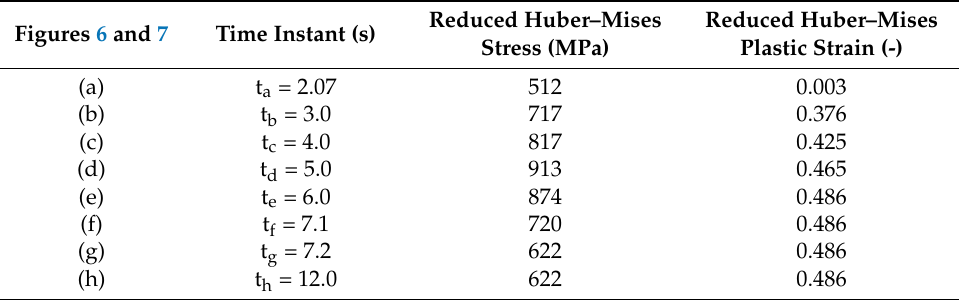
Table 3. Juxtaposition of maximum reduced Huber–Mises stress and strain values in a sheet being cut for selected time instants during numerical cutting